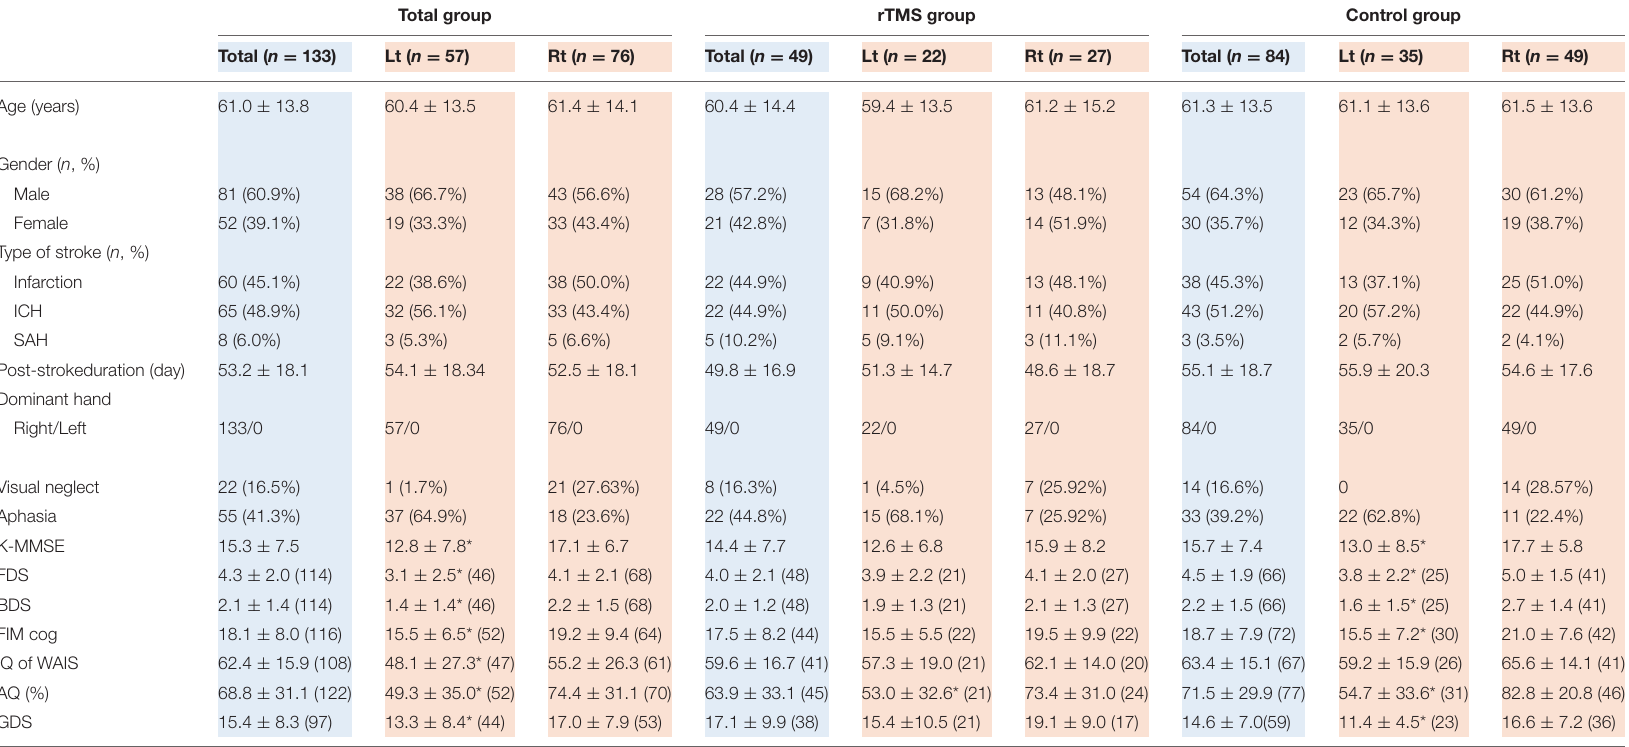
TABLE 1 | Demographic characteristics in total subjects ( n =